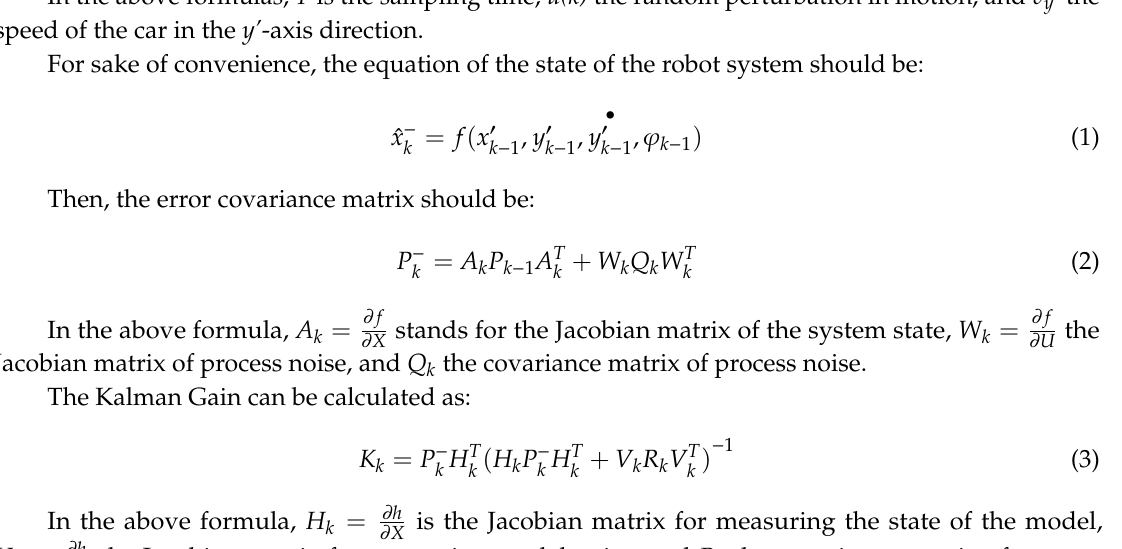
Figure 8. The surface schematic diagram of the fuzzy control rules.